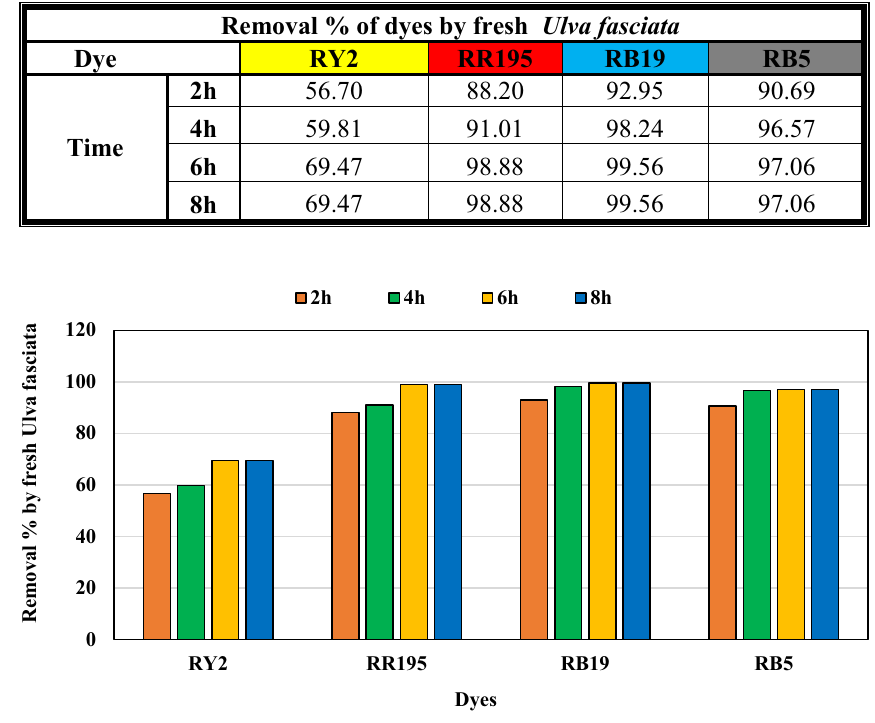
Removal % of dyes by fresh Ulva fasciata